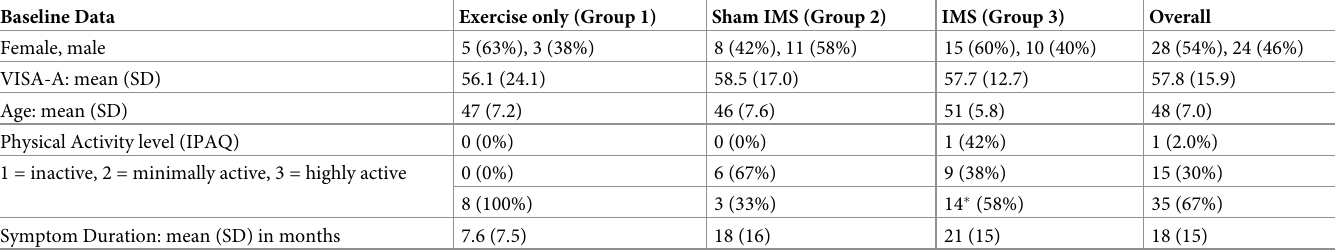
Table 1. Baseline characteristics of study subjects.